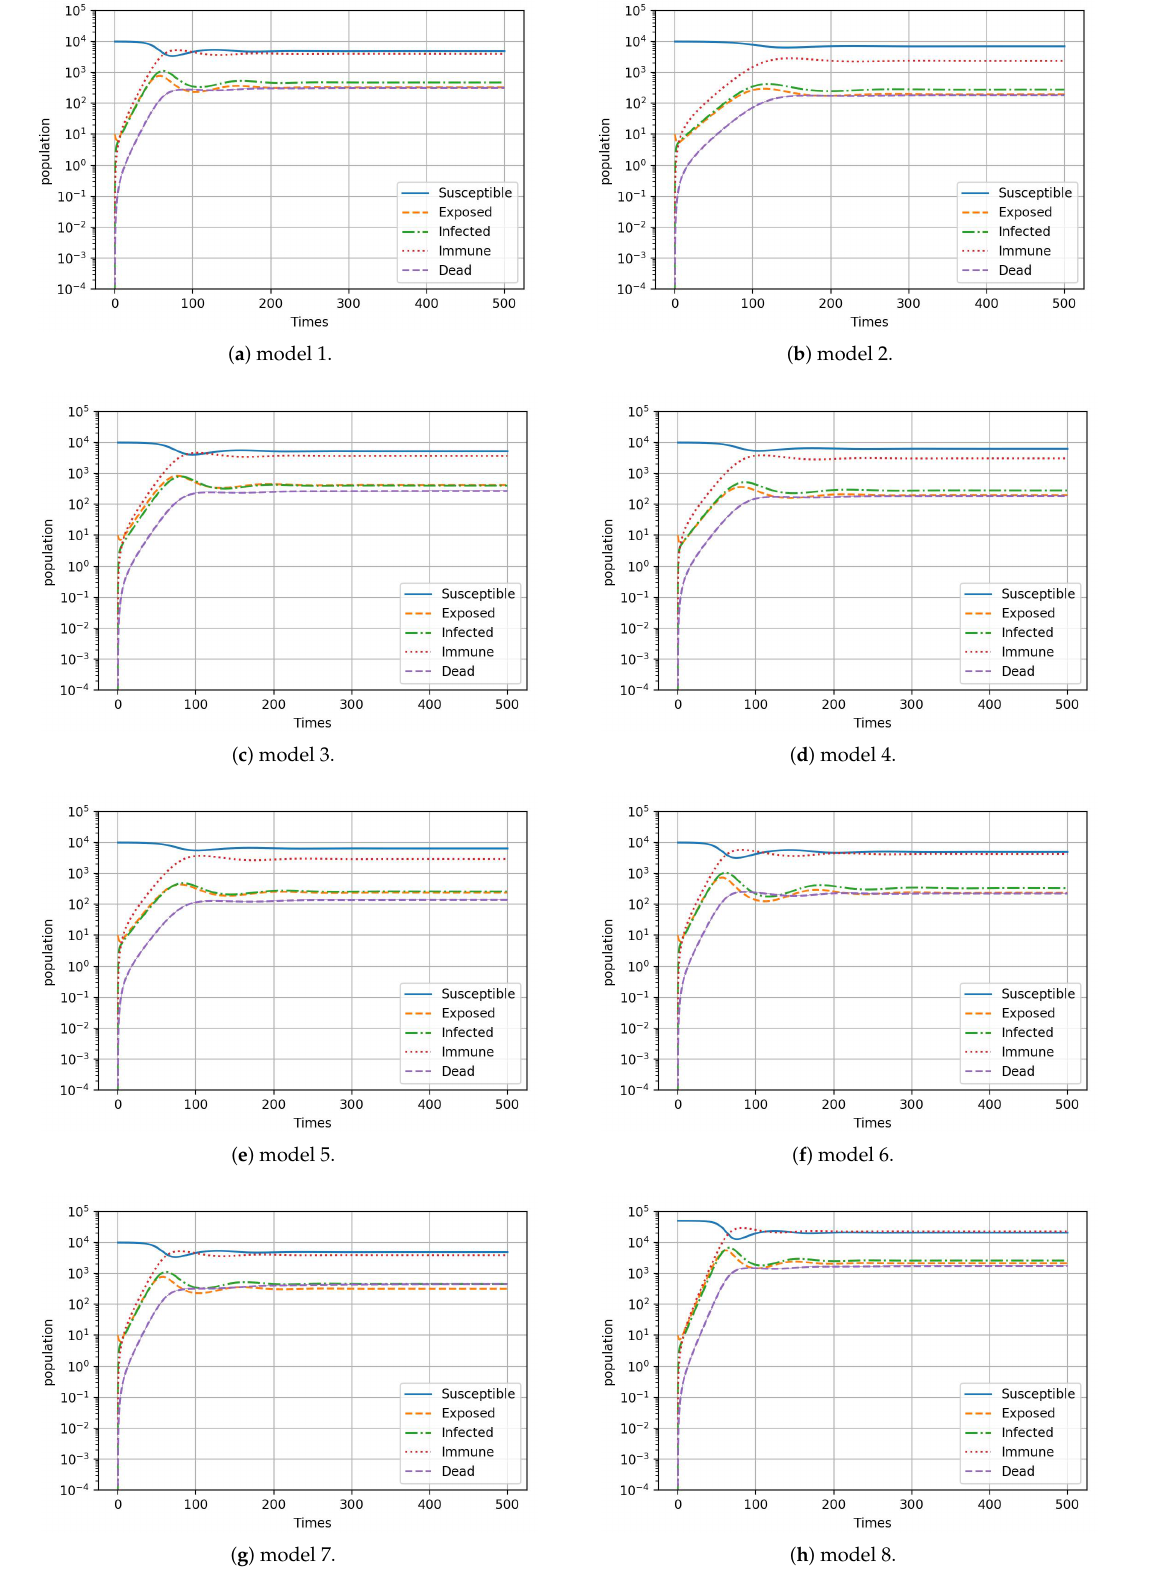
Figure 5. Simulation